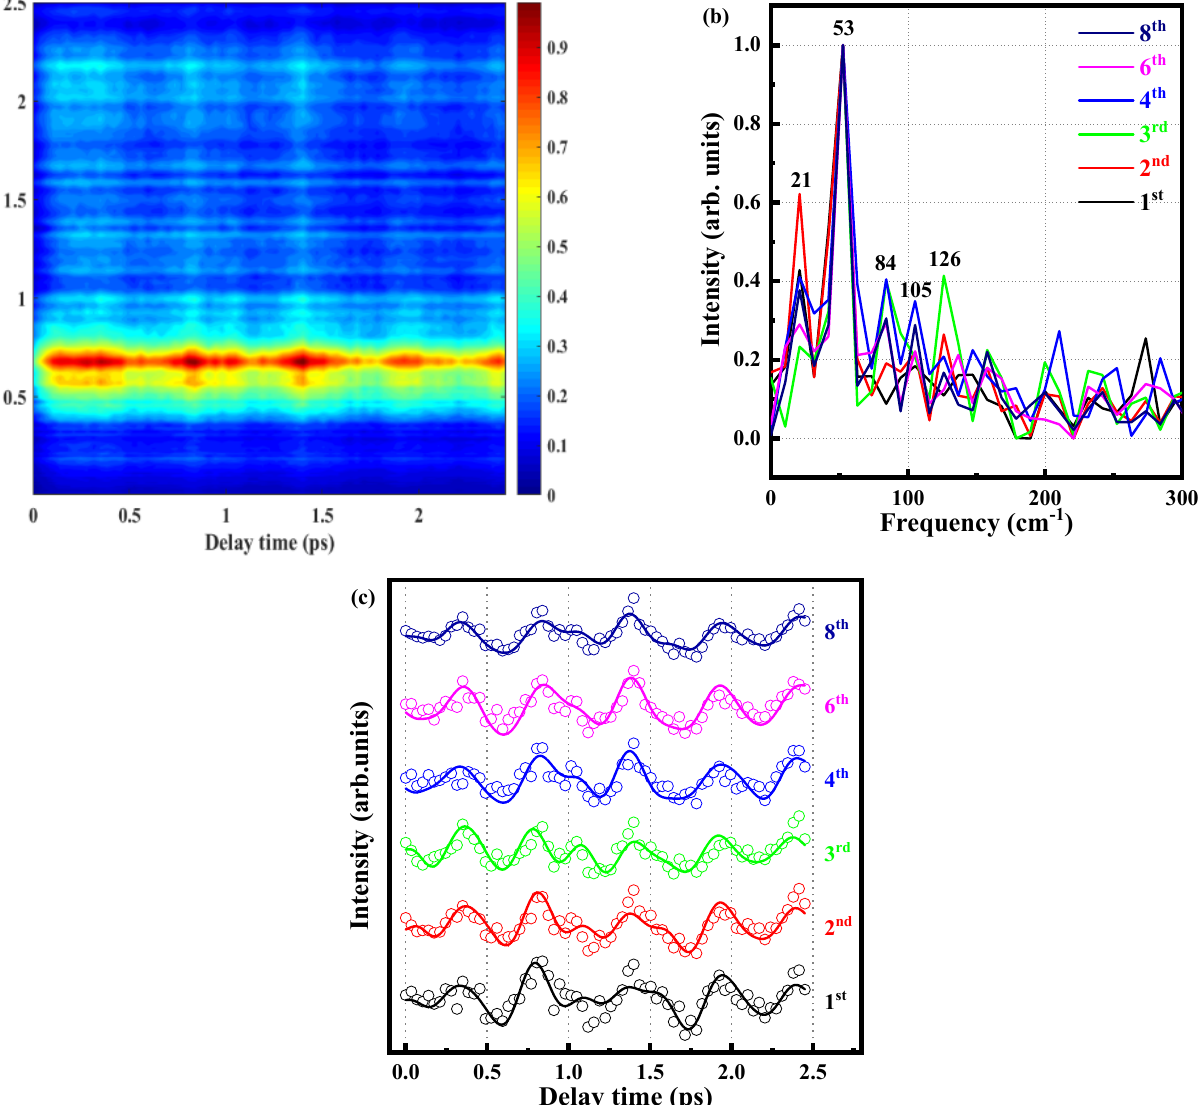
Figure 6. ( a ) Time ‐ resolved photoelectron spectrum obtained with a 288.3 nm pump pulse and 800 nm probe pulse. ( b ) The spectrum obtained by Fourier transform of the residual data at the fourth peak. ( c ) Signal intensities of the six peaks as functions of delay time. Experimental data are given as open circles, while solid lines are fitted results.